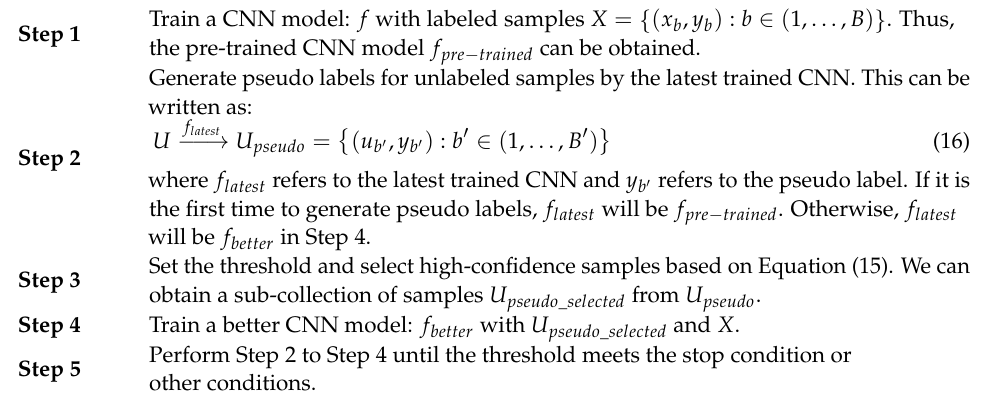
Algorithm 1. The algorithm of accomplishing the semi-supervised classification task based on CNN and selecting samples according to the threshold of confidence